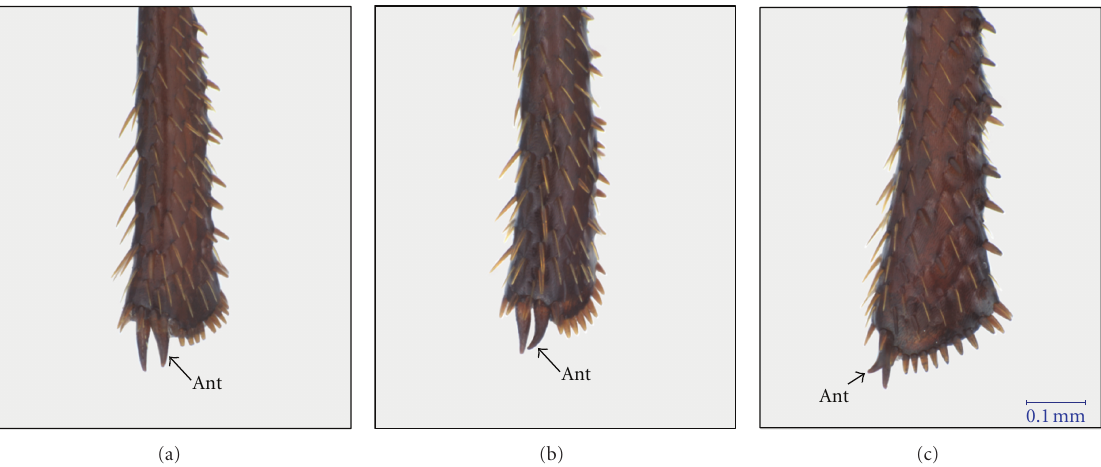
Figure 3: External characteristics of mesothoracic tibiae for determining sex of A. diaperinus adults: (a) anteroventral view of parallel apical spurs on females; (b) and (c) anteroventral and anterior views, respectively, of apical spurs on males, note curvature of anterior spur. Ant, anterior spur; scale bar applicable to all frames; tibiae from left legs